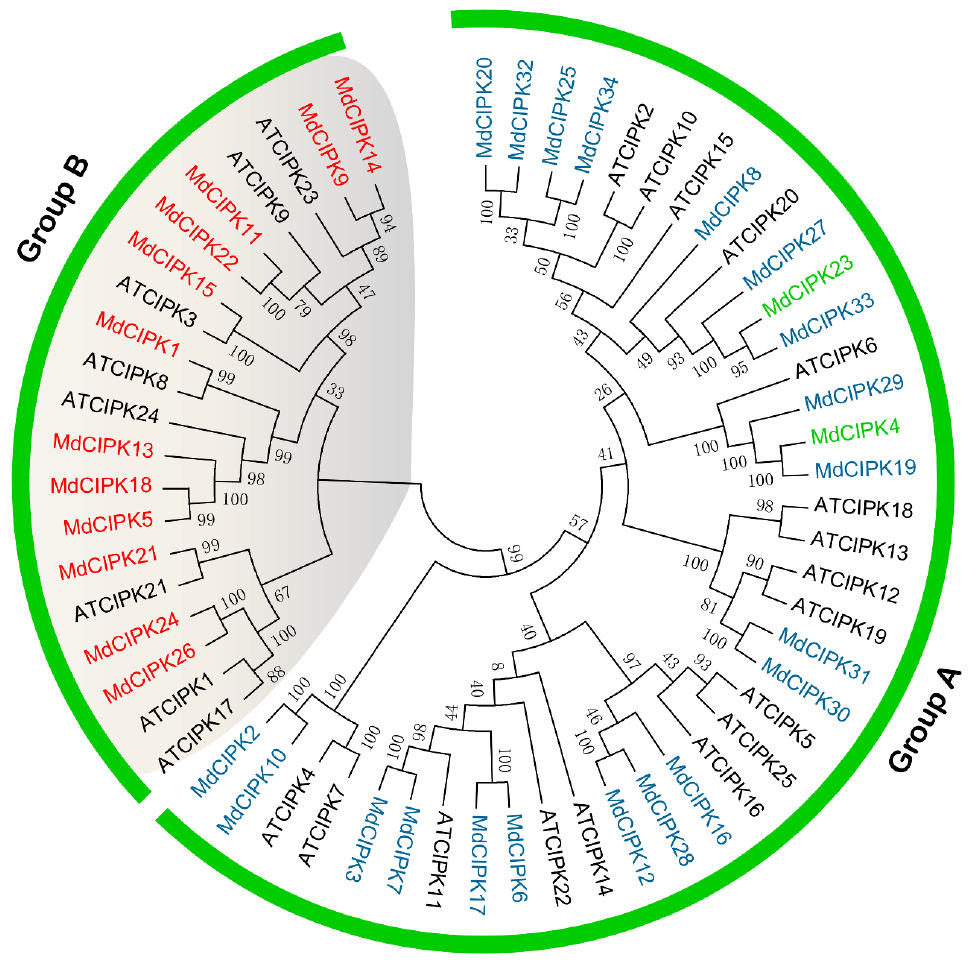
Figure 2. Phylogenetic relationship of apple and Arabidopsis CIPK proteins. The phylogenetic tree was constructed using the neighbor — joining method by MEGA 6.0. The bootstrap values of 1000 replicates were calculated at each node. The model was p-distance and the pattern among Lineages was Same (Homogeneous). The gaps and missing data treatment were complete deletion. The CIPK domain protein sequences, 34 from apple (MdCIPKs) and 25 from Arabidopsis (AtCIPKs, black color), were aligned by MUSCLE. The proteins were classified into 2 distinct subgroups, Group A and Group B. Red indicates MdCIPK genes with exon-poor in Group B, blue indicates MdCIPK genes with no introns in Group A, and green indicates MdCIPK genes containing introns in Group A.